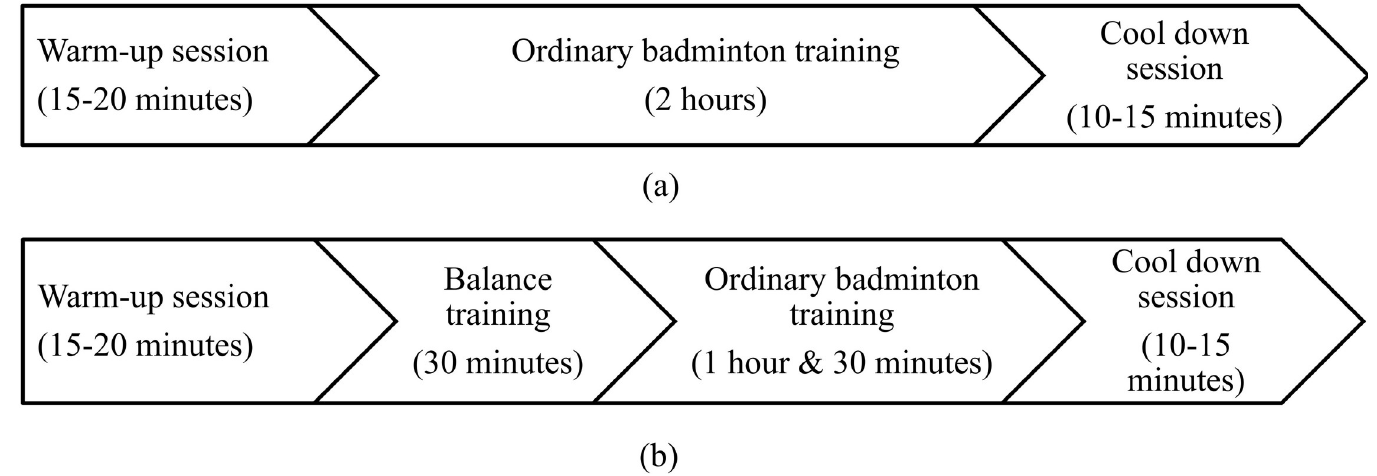
Fig 2. Flow of the training protocol in each day: (a) control group (b) intervention group.